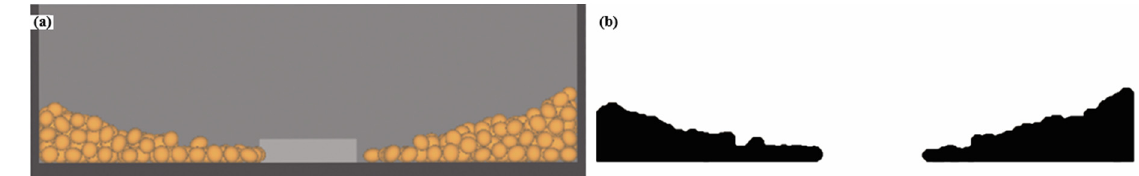
Figure 21. ( a ) DEMSLab simulation snapshot of the piling angles and ( b ) its binarization image.